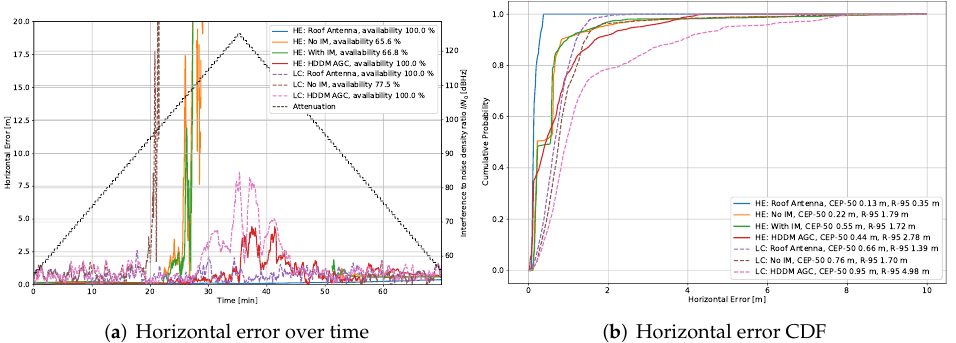
Figure A26. Interference #8: Filtered pulsed noise with 35MHz bandwidth, 50% duty cycle, and 1ms pulse width.